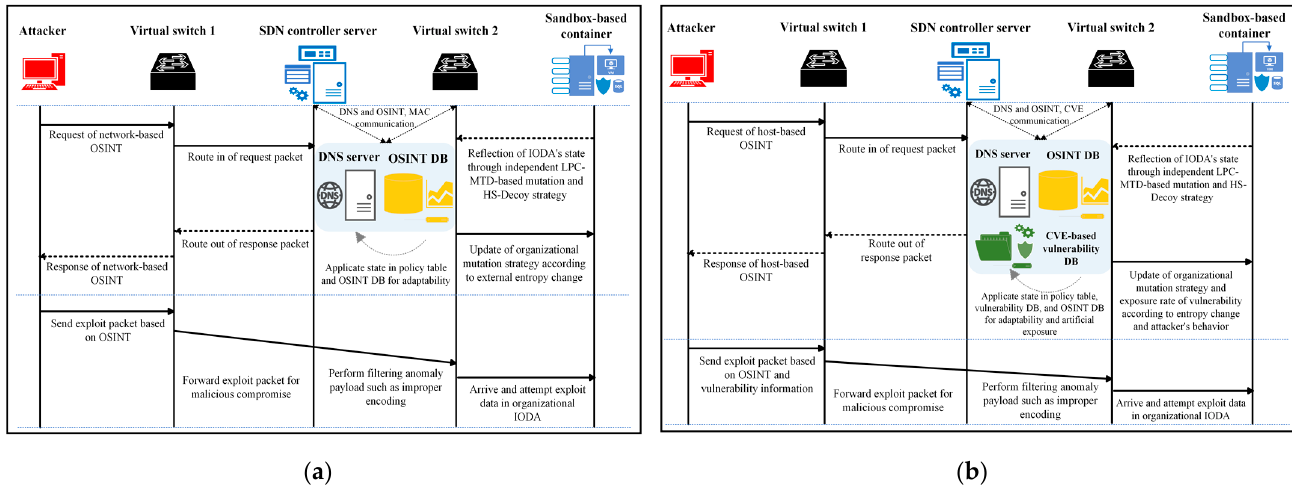
Figure 6. Examples of deceptive sequences with LPC-MTD in HS-Decoy-based sandboxes. ( a ) Mutation sequence of network-based OSINT elements, ( b ) mutation sequence of platform and host-based OSINT elements.